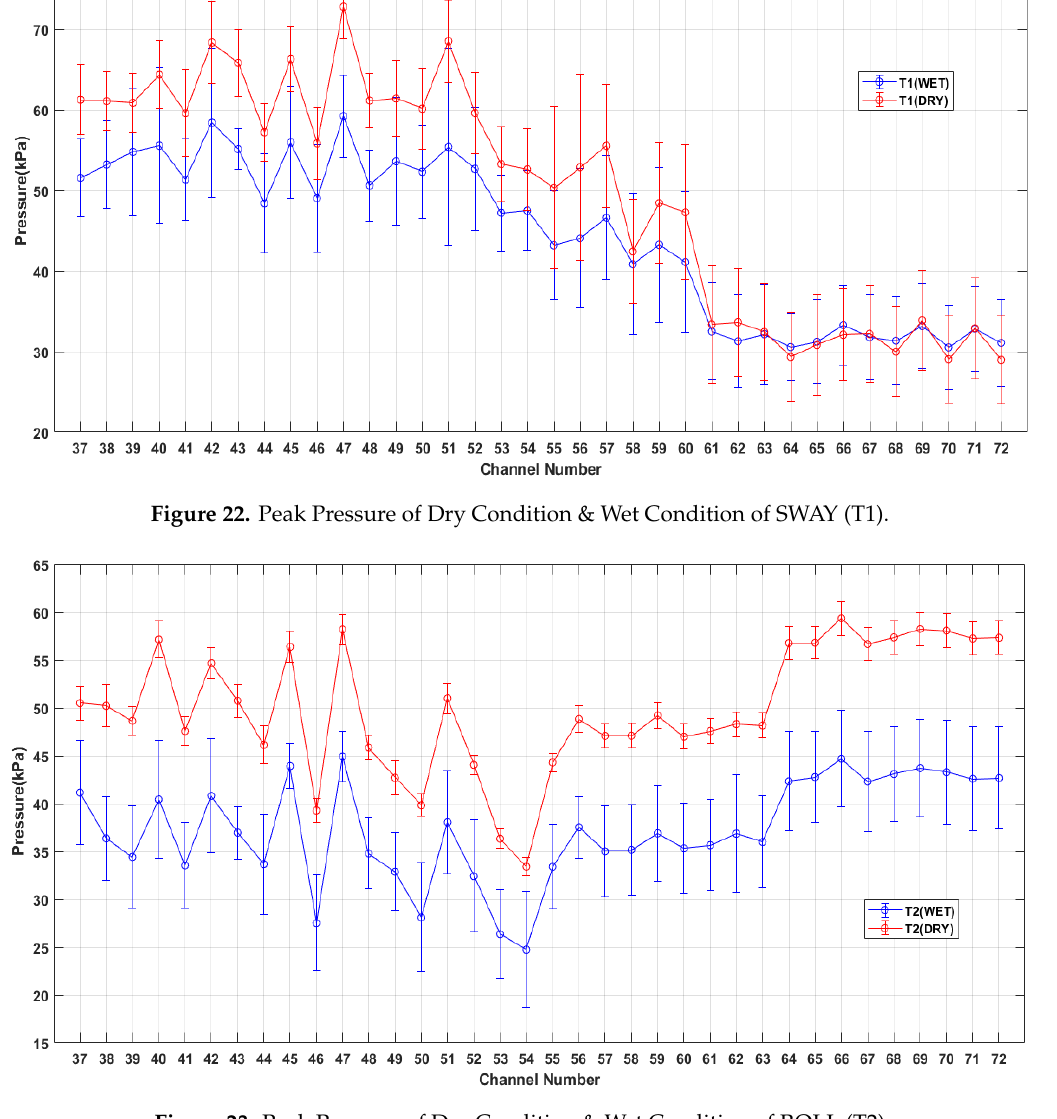
Figure 23. Peak Pressure of Dry Condition & Wet Condition of ROLL (T2)